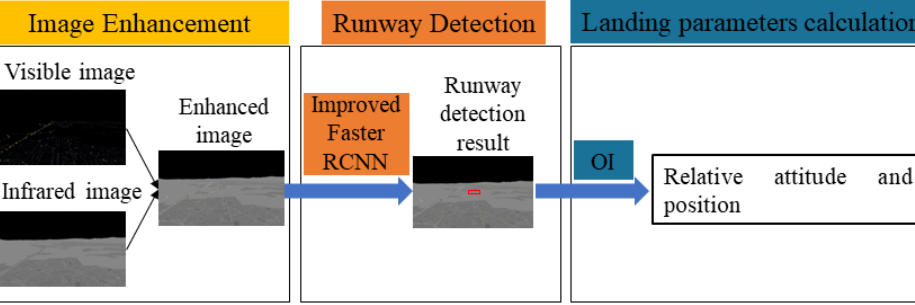
Figure 2. Structure of the proposed navigation